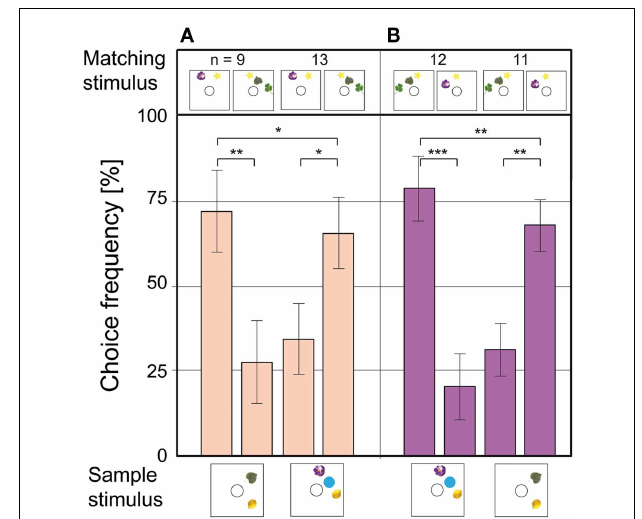
composed of different elements. (D–G) Bees trained to discriminate between 2 and 3 are tested on stimuli with (D) 3 and 4 elements, (E) 4 and 5 elements, (F) 5 and 6 elements, (G) 4 and 6 elements. n Denotes number of bees per condition. Error bars show standard error. ***Denotes statistically significant difference at p < 0.001, **denotes p < 0.01, *denotes p < 0.05, and O denotes p > 0.05. Modified from Gross et al. (2009).